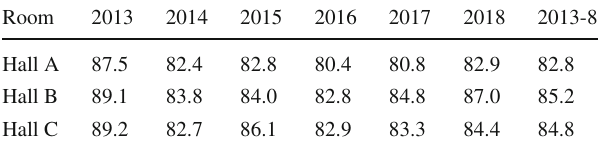
Table1 Annualaverageactivityconcentrationof 222 Rn(Bqm − 3 )from 2013 to 2018. Their statistical uncertainties are approximately 0.07% whereas the instrument calibration error is 3%. The last column is the annual average for the 6 years of